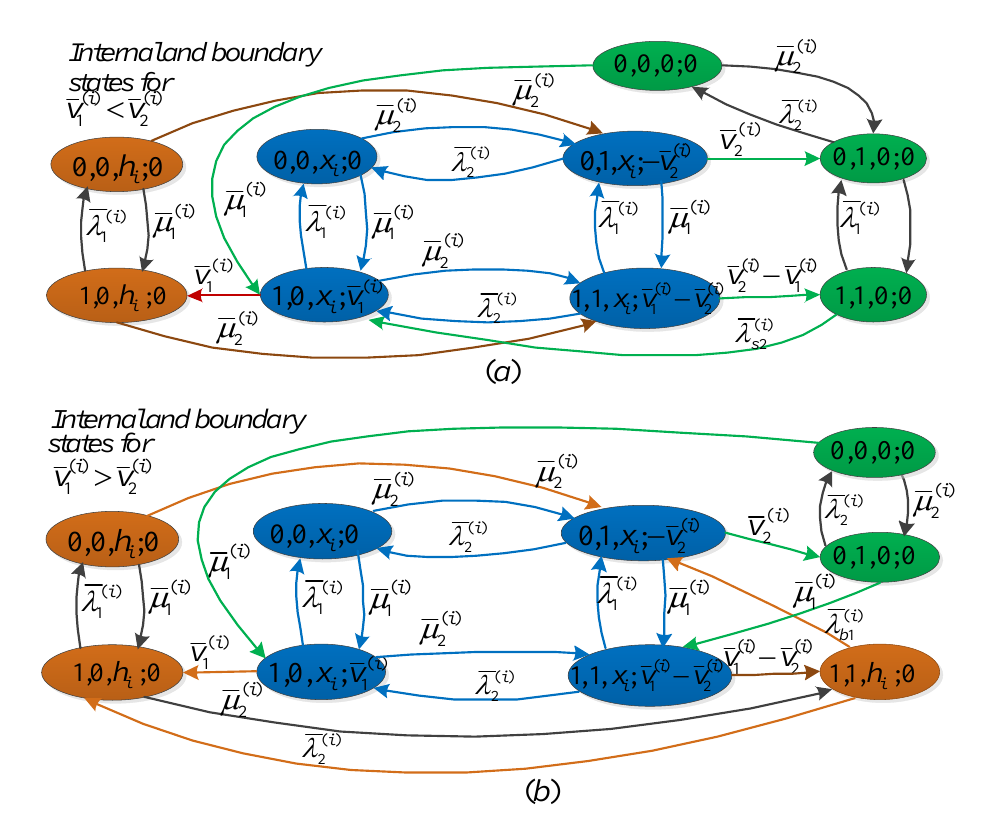
Figure 9. State transition diagrams